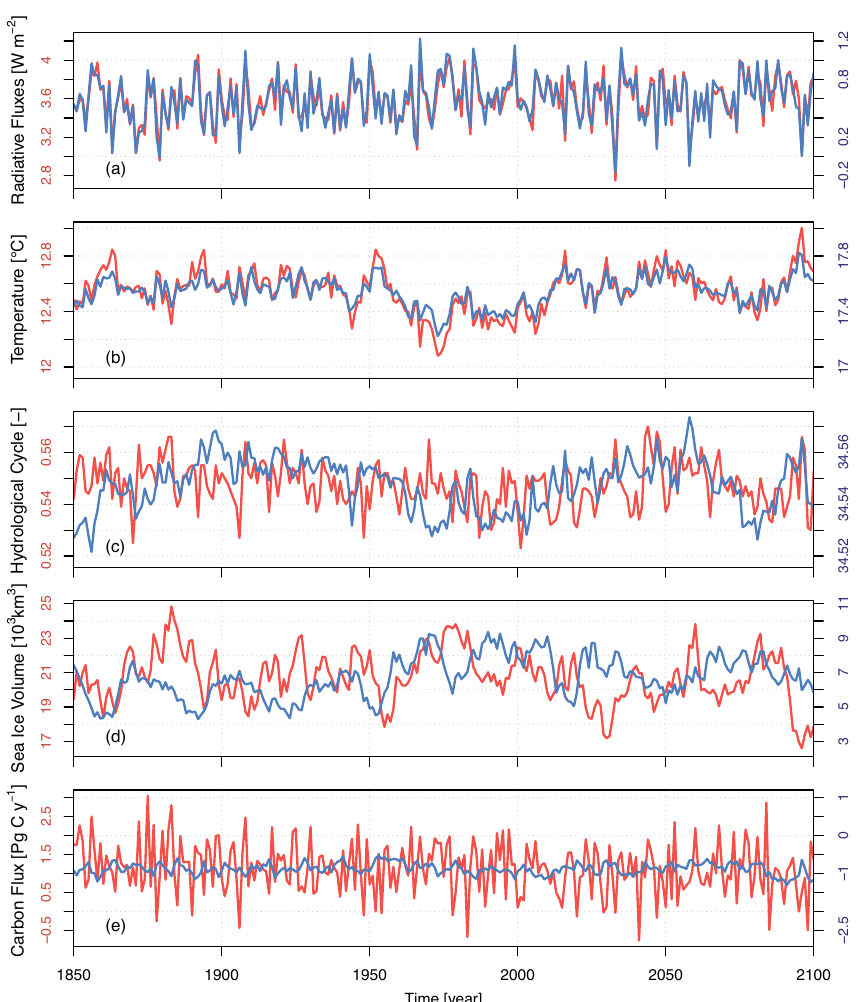
Figure 2. Time series of various climate indices along the 250-year-long control simulation. (a) Net radiative fluxes at the top of the atmosphere (in red, left y axis) and surface (in blue, right y axis) are used to assess the stability of the climate energy flow in the model; (b) near-surface global average temperature (in red, left y axis) and global-averaged sea surface temperature (in blue, right y axis); (c) soil wetness index (in red, left y axis) and sea surface salinity (in blue, right y axis) are used as proxy of the hydrological cycle; (d) sea-ice volume in the Northern Hemisphere (in red, left y axis) and in the Southern Hemisphere (in blue, right y axis) are used to evaluate the stability of the cryosphere component in CNRM-ESM1; (e) global carbon fluxes over land (in red, left y axis) and over ocean (in blue, right y axis) are used to assess the equilibration of the global carbon stock. For carbon fluxes, positive (negative) fluxes indicate an uptake (outgassing) of CO 2 by land or